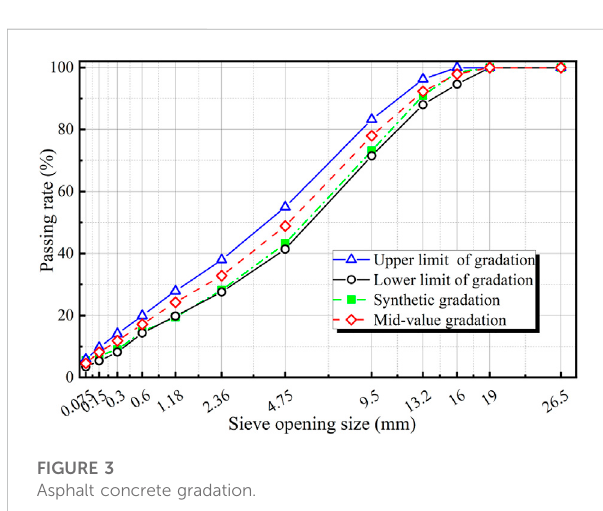
FIGURE 3 Asphalt concrete